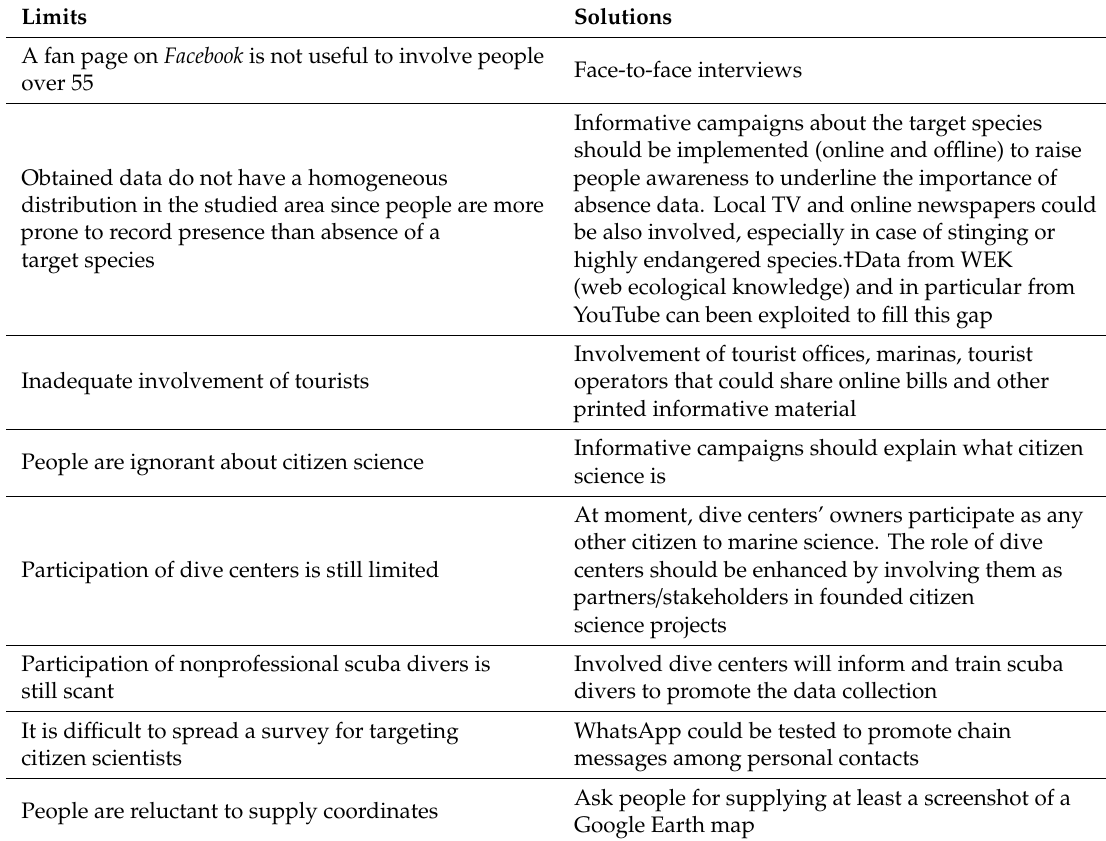
Table 2. Limits in the use of social platforms for marine citizen science projects and how to fix them.